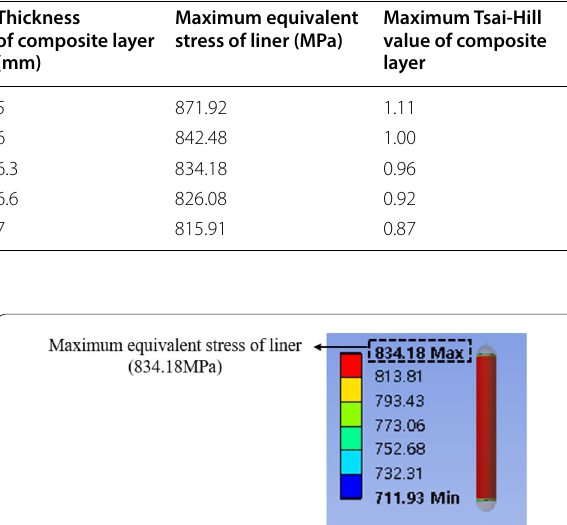
Table 6 Material properties of E‑glass fiber and